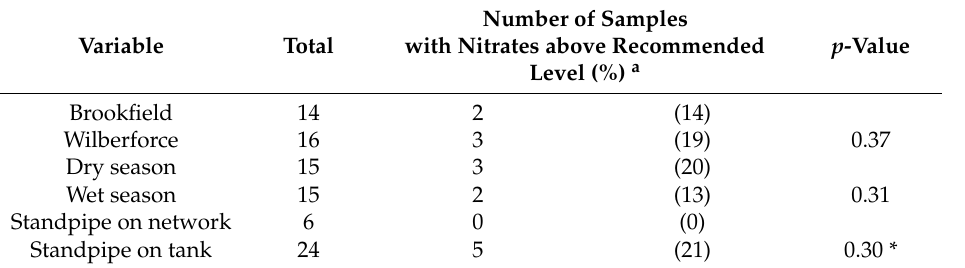
Table 5. Number of samples where the nitrates were above the recommended level in samples from standpipes in Freetown Sierra